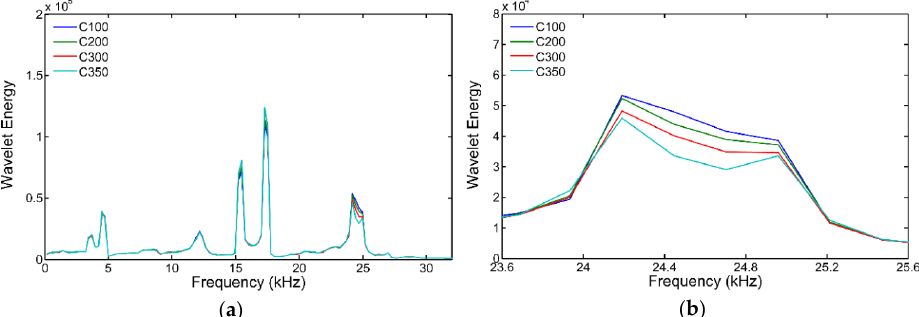
Figure 7. Wavelet energy of one I ‐ section of the ground floor of specimen FD. (a) Complete frequency range; (b) Zoom around the 25 kHz natural frequency.